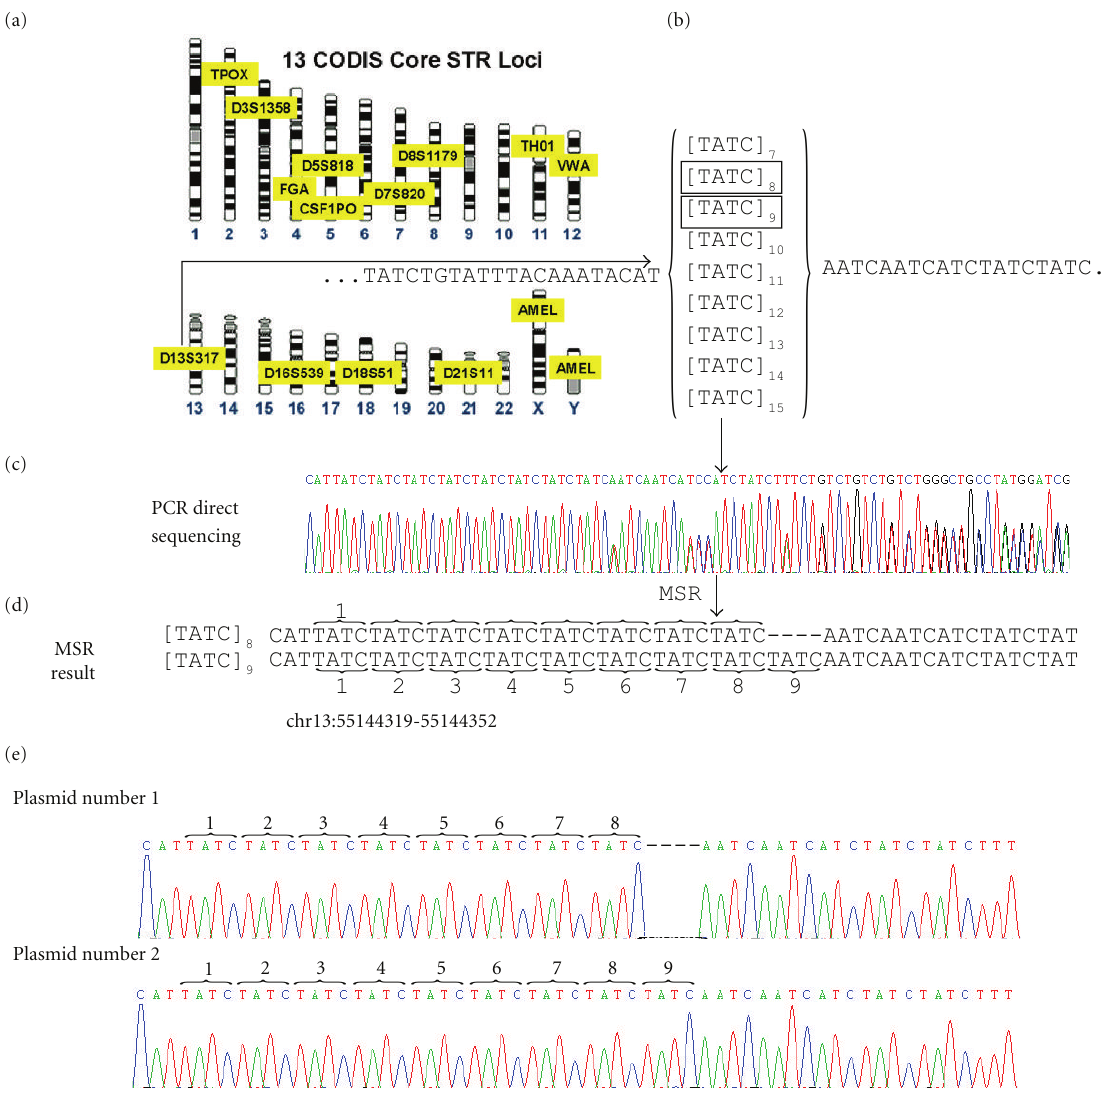
Figure 3: Experimental confirmation of one CODIS-STR locus identified by the Mixed Sequencer Reader. (a) The FBI CODIS Core STR Loci map (adapted from http://www.cstl.nist.gov/strbase/fbicore.htm). The D13S317 locus (chromosome 13:55144219-55144352 region) was randomly selected for analysis in this study. (b) The common repeat structure in the D13S317 locus in each person represents the com- bination of 2 structures in the CODIS database. (c) The direct sequencing chromatography trace of a PCR product containing the D13S317 locus at chromosome 13:55144219-55144352. (d) The MSR results indicated the presence of 8 and 9 copies of (TATC) within the individual. (e) The sequences of cloned PCR products were consistent with the MSR prediction. One of plasmid contained 8 copies of (TATC) (e.g., plasmid 1); whereas the other plasmids contained 9 copies of [TATC] (e.g., plasmid